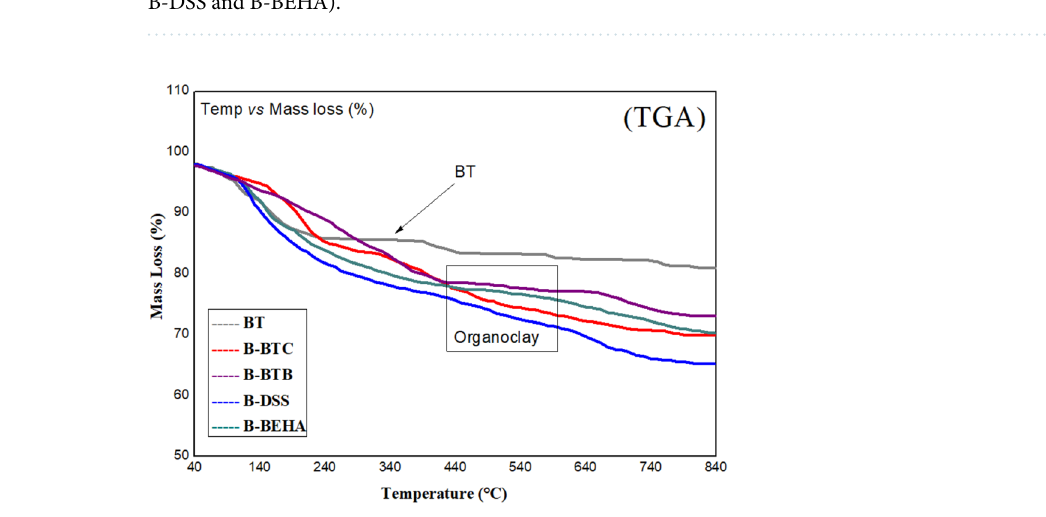
Figure 4. TGA curves of pristine clay BT and modified bentonite